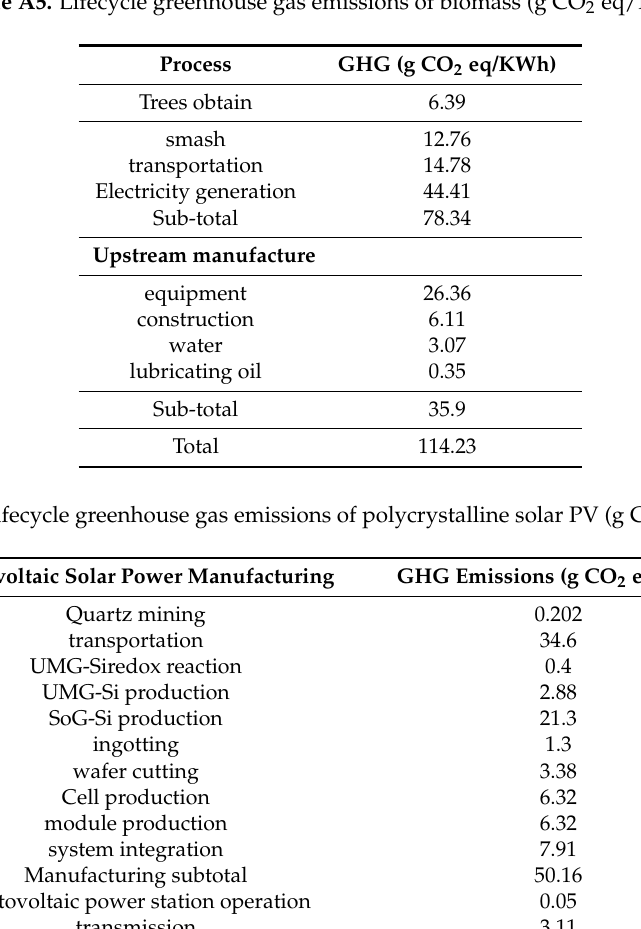
Table A5. Lifecycle greenhouse gas emissions of biomass (g CO 2 eq/KWh).